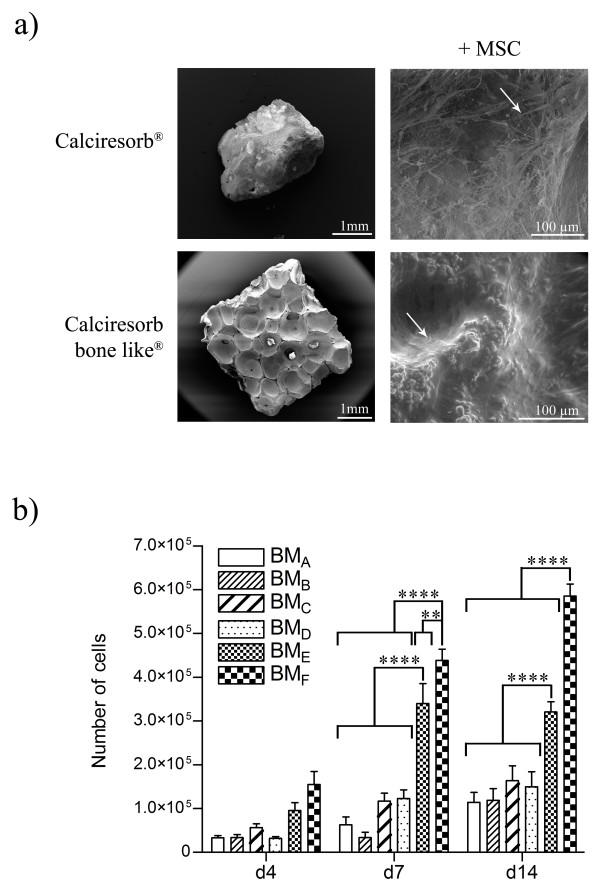
Physical characteristics and biocompatibility of biomaterials and mesenchymal stromal cell (MSC) proliferation on the different biomaterials. (a) Representative scanning electron microscopy images of 'Calciresorb' (BMA) and 'Calciresorb bone like' (BMF) biomaterial surfaces are shown. MSCs were loaded on these two biomaterials and grown in platelet lysate (PL) medium. MSC colonization on the various biomaterials was evaluated by scanning electron microscopy at 14 days of culture. Arrows indicate cells on biomaterials. (b) MSCs loaded on the various biomaterials at low cell seeding density (100 × 103 cells per biomaterial) were grown in PL medium for 14 days. The number of cells on the different biomaterials was evaluated at days 4, 7, and 14. The data are expressed as mean ± standard error of the mean. A statistically significant difference between individual conditions was revealed by analysis-of-variance test followed by Student Newman-Keuls test. **P <0.01, ****P <0.0001. d, day.